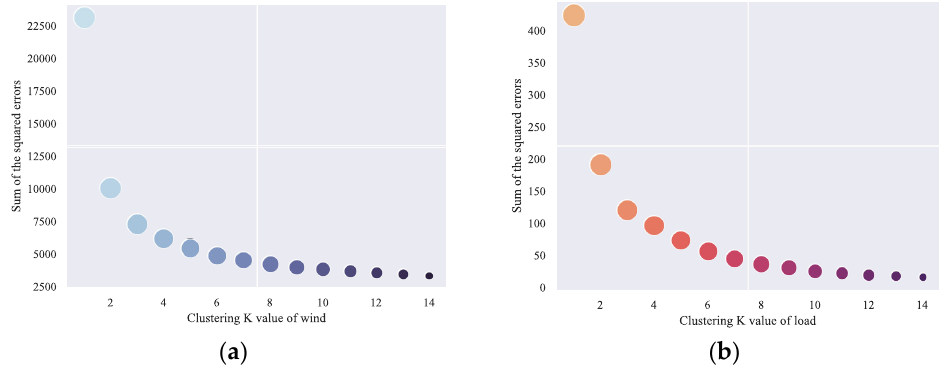
Figure 6. ( a ) The SSE of wind power. ( b ) The SSE of variable load.